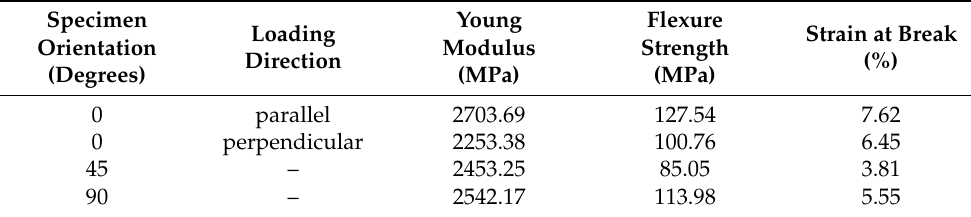
Table 2. Flexure test results for